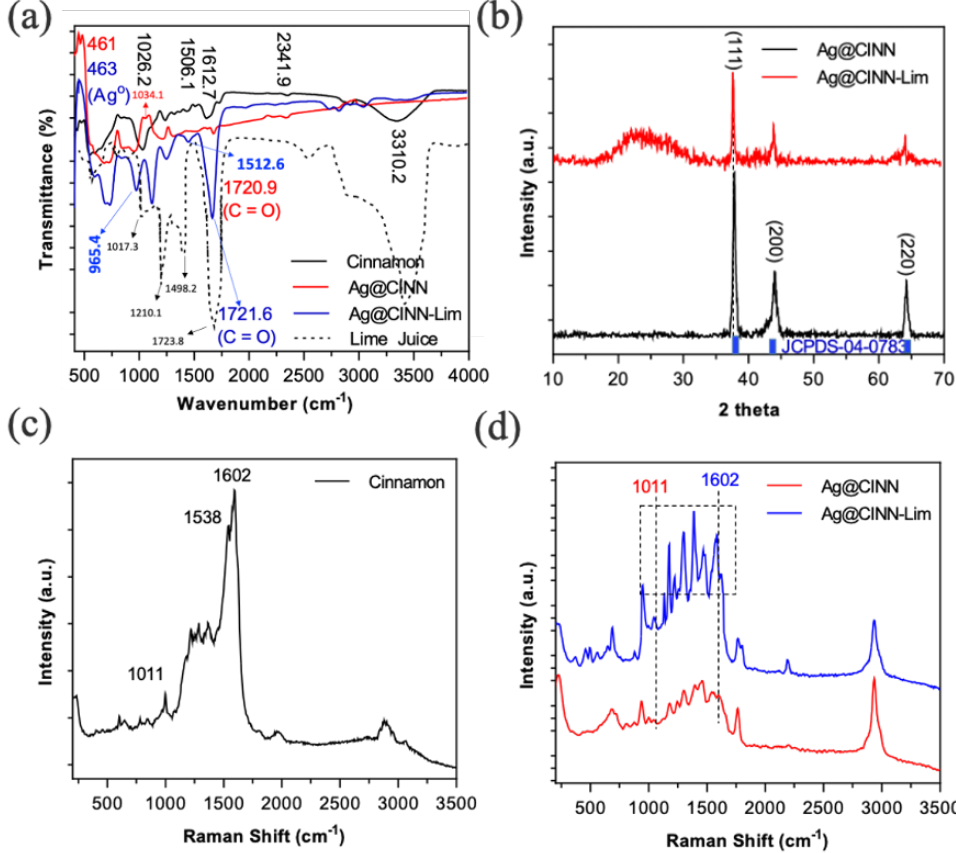
Figure 3. ( a ) FTIR spectra showing the interaction of metabolites with as-prepared nanoparticles. ( b ) XRD spectra showing diffraction peaks at 2 theta. ( c ) The Raman spectra of pure cinnamon. The spectra at 1602, 1538, and 1011 cm − 1 correspond to -C=C- and C-C stretching and ether group deformation, confirming the eugenol and secondary metabolites present in cinnamon. ( d ) The Raman spectra of as-prepared samples. The elongation of peaks at 1011 and 1602 cm − 1 is due to the capping of metabolites. The box represents the section in which the elongation of peaks is occurring in the vicinity of lime.